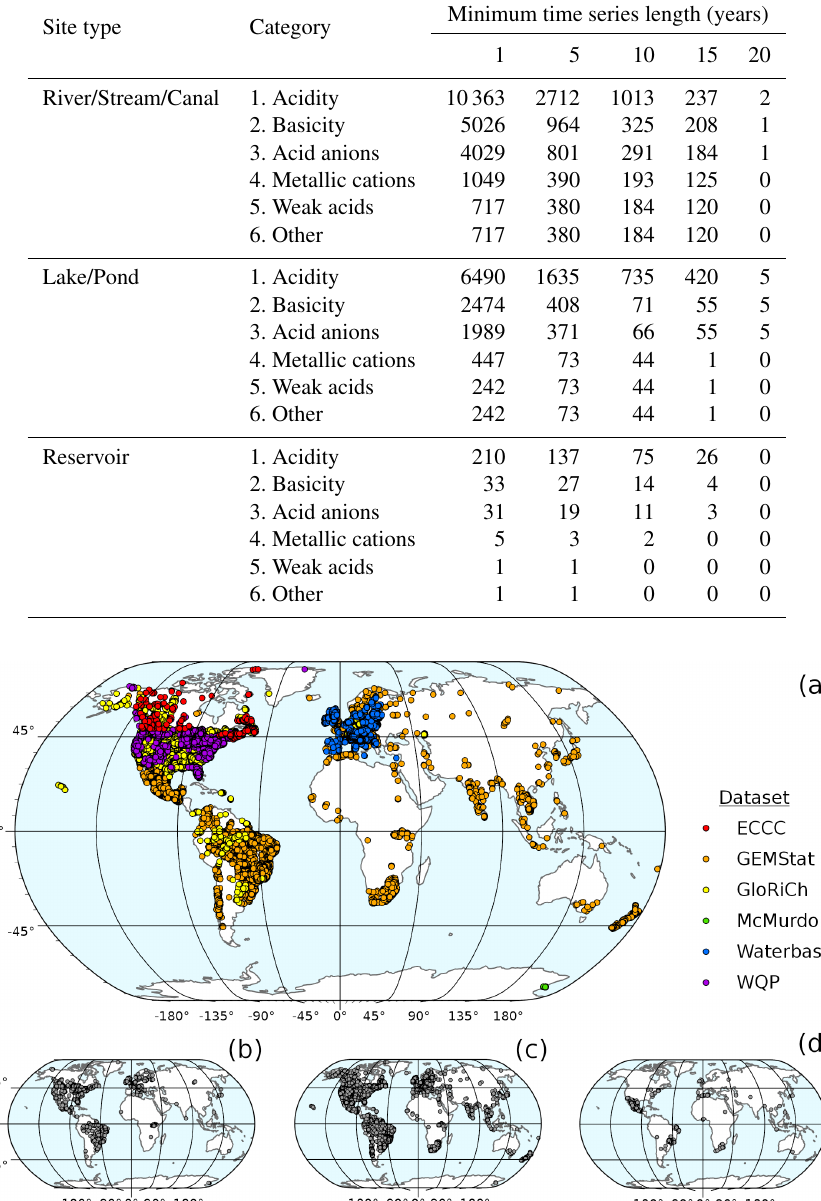
Figure 2. Sample sites in the SWatCh database, coloured by dataset source (a) and separated by site type: lakes/ponds (b) , rivers/streams/- canals (c) , and reservoirs (d) . Points overlap where sites are in close vicinity. Natural Earth projection is used, and the scales are as